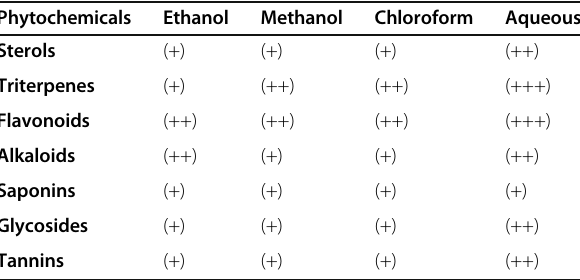
Table 4 Qualitative analysis of the phytochemical constituents of multi herbal formulation (AKSS16-LIV01) Phytochemicals Ethanol